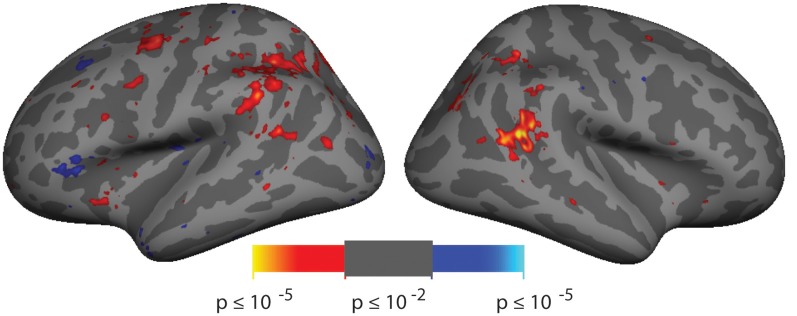
Spatial cueing group-averaged activation. A group-average analysis (N = 10) of invalidly (hot colors) vs. validly (cool colors) cued targets (p < 0.01, uncorrected). Activation is observed in right hemisphere around the posterior end of the superior temporal sulcus (STS) near the border with the parietal lobe.